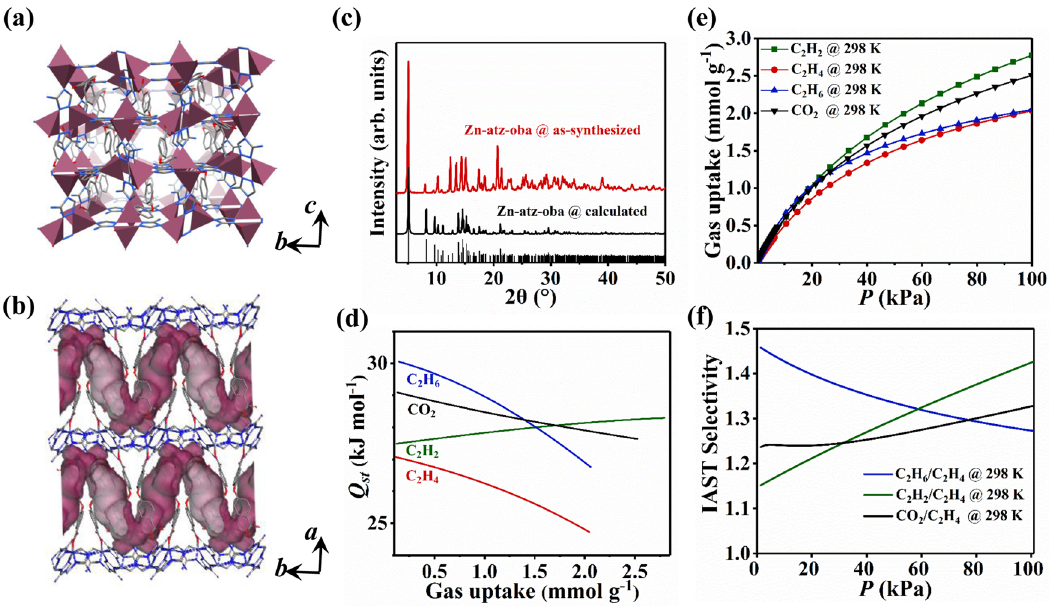
Fig. 2 Pore structure and gas sorption properties of Zn-atz-oba. Views of ( a ) the pore structure and ( b ) the Connolly surface of Zn-atz-oba when viewed along the a - and c -axis, respectively. H-atoms are omitted for clarity. ( c ) PXRD patterns con fi rm the bulk phase purity of Zn-atz-oba. ( d ) Adsorption enthalpy pro fi les ( Q st ) for Zn-atz-oba. ( e ) Gas sorption isotherms of Zn-atz-oba at 298 K. ( f ) Binary 1:1 (v/v) IAST selectivity of Zn-atz-oba at 298 K. color codes for ( a ) and ( b ): carbon = gray; nitrogen = blue; oxygen = red; Zn polyhedra in ( a ) = tyrian purple; Connolly surface in ( b ) = purple.